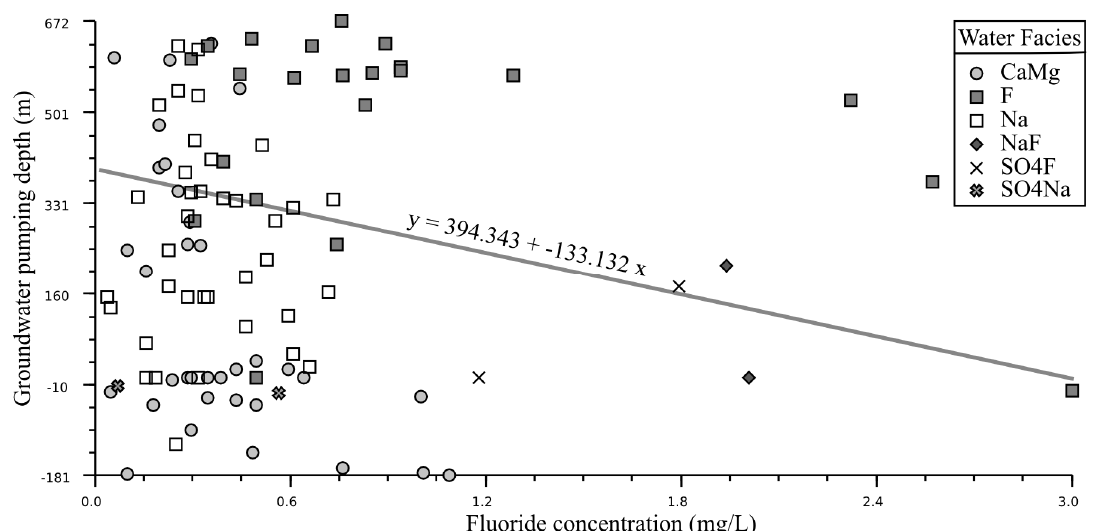
Fig. 5 – Relationship between fluoride concentration and groundwater pumping